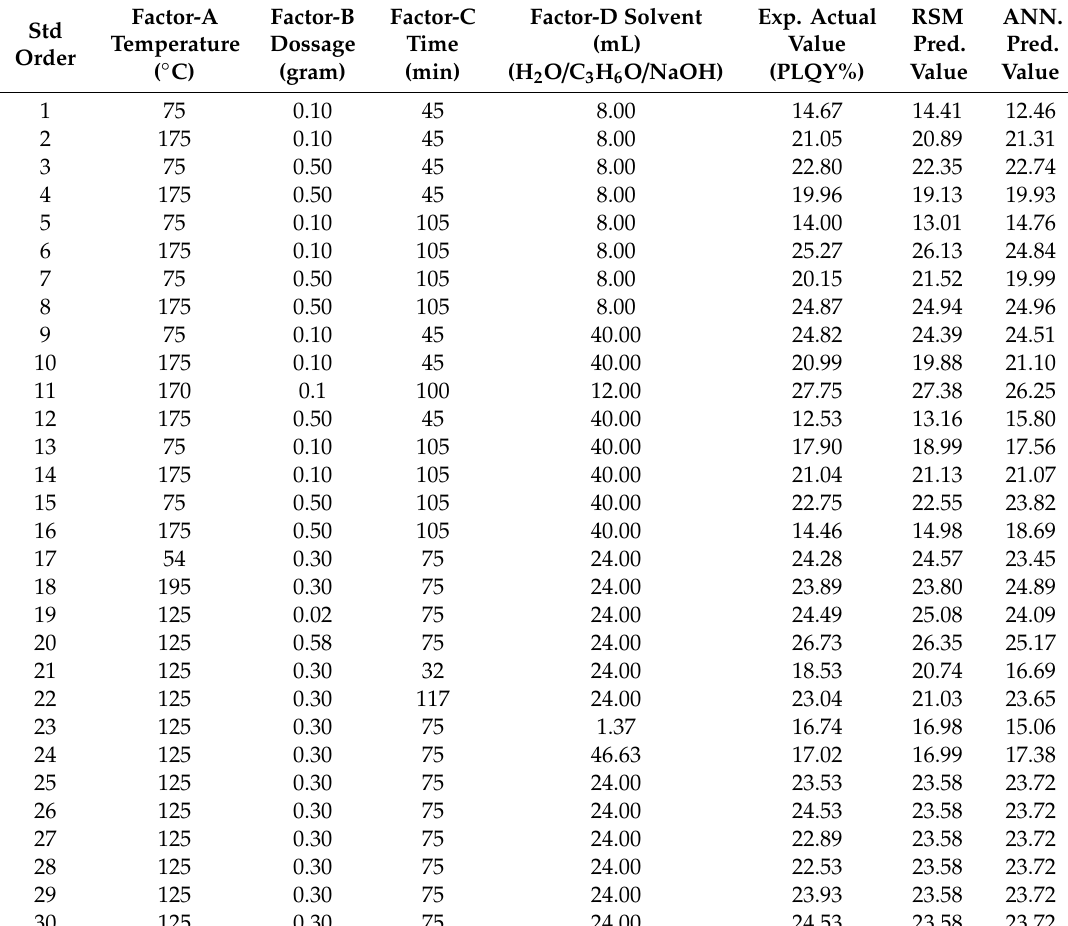
Table 7. Response surface methodology and artificial neural